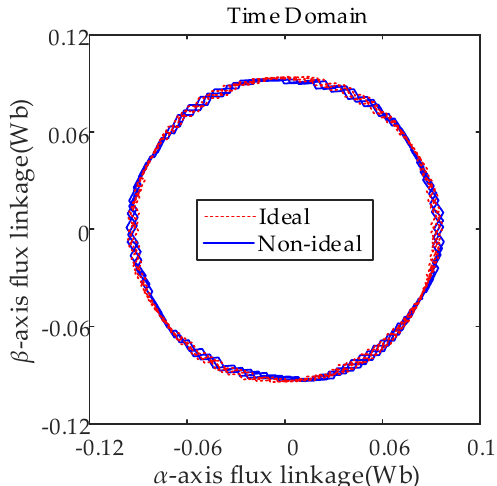
Figure 25. Flux linkage trajectory comparison.